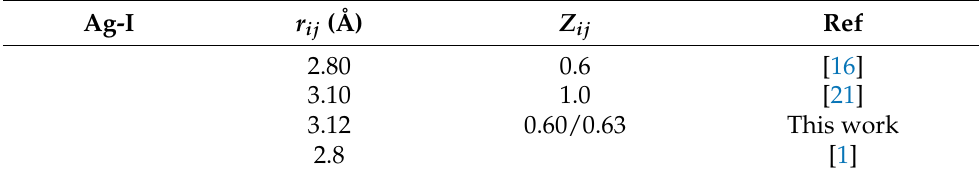
Table 3. Comparison of Ag-I PDF. The temperature at 300 K.